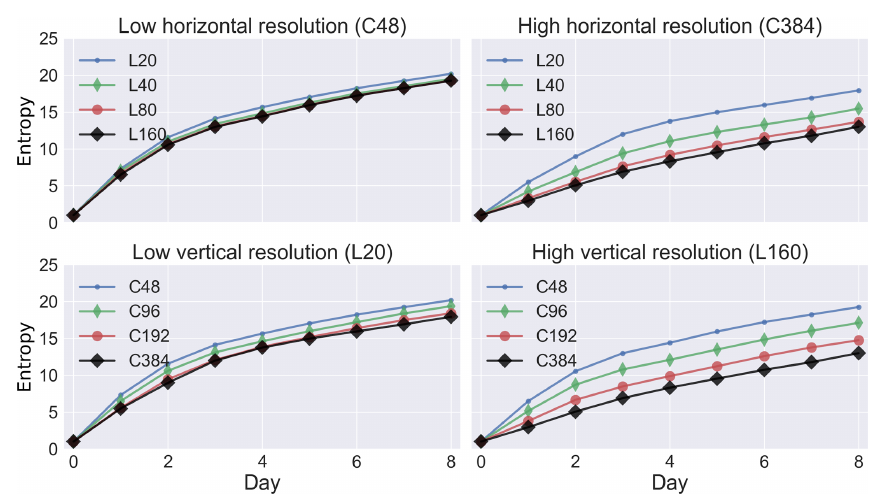
Figure 6. Same as Fig. 4 but with entropy instead of maximum mixing ratio as a diagnostic for numerical diffusion. The entropy is initialized on day 0 with a value of 1. Pure advection conserves entropy but diffusion increases it.